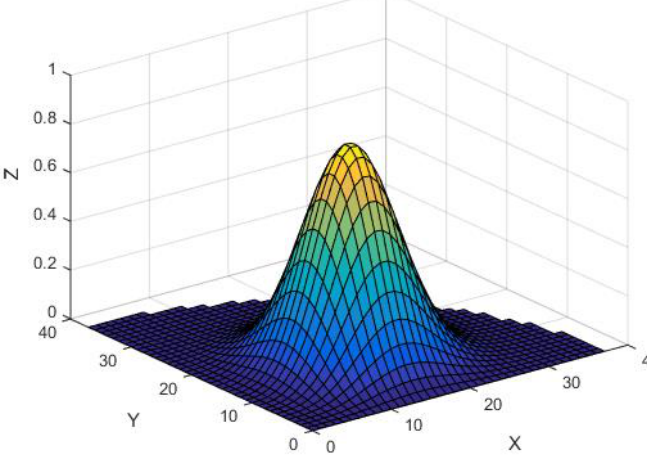
Figure 5. Perspective of Hermite analytic function H 12 .